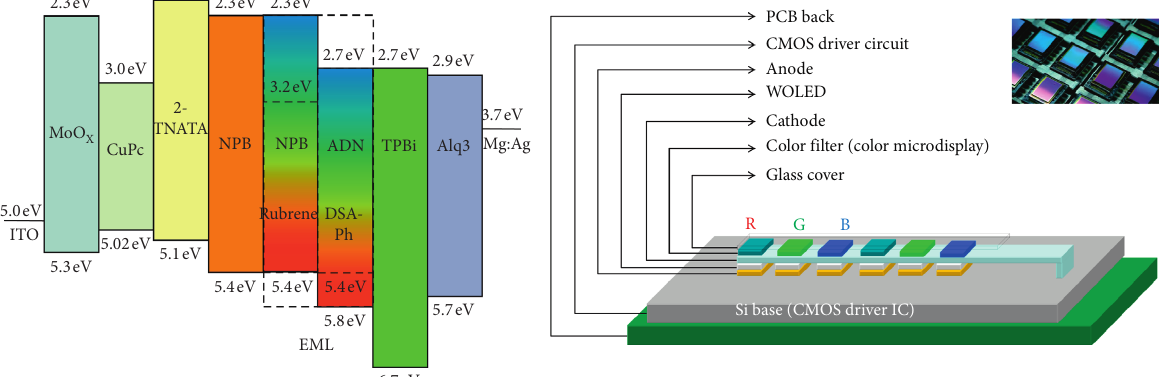
Figure 1: Materials and structure of OLED